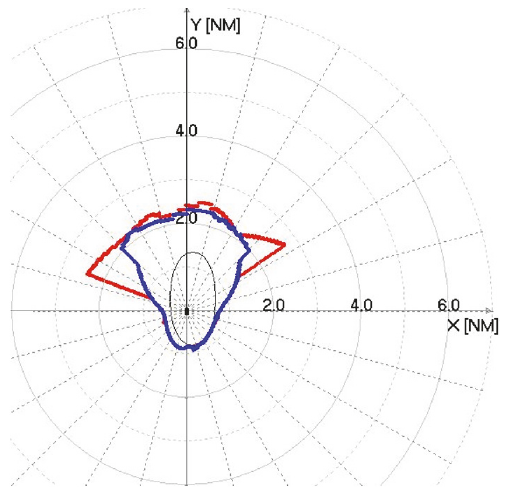
Figure 32: Action lines for stand-on encounter with a target, whose true speed is 18 knots. Manoeuvres to starboard only are considered and they are additionally limited by risk of successive high wave attack and resonance. Wind of 17 [m/s] and wave from 0 ∘ (blue) and 280 ∘ (red) are